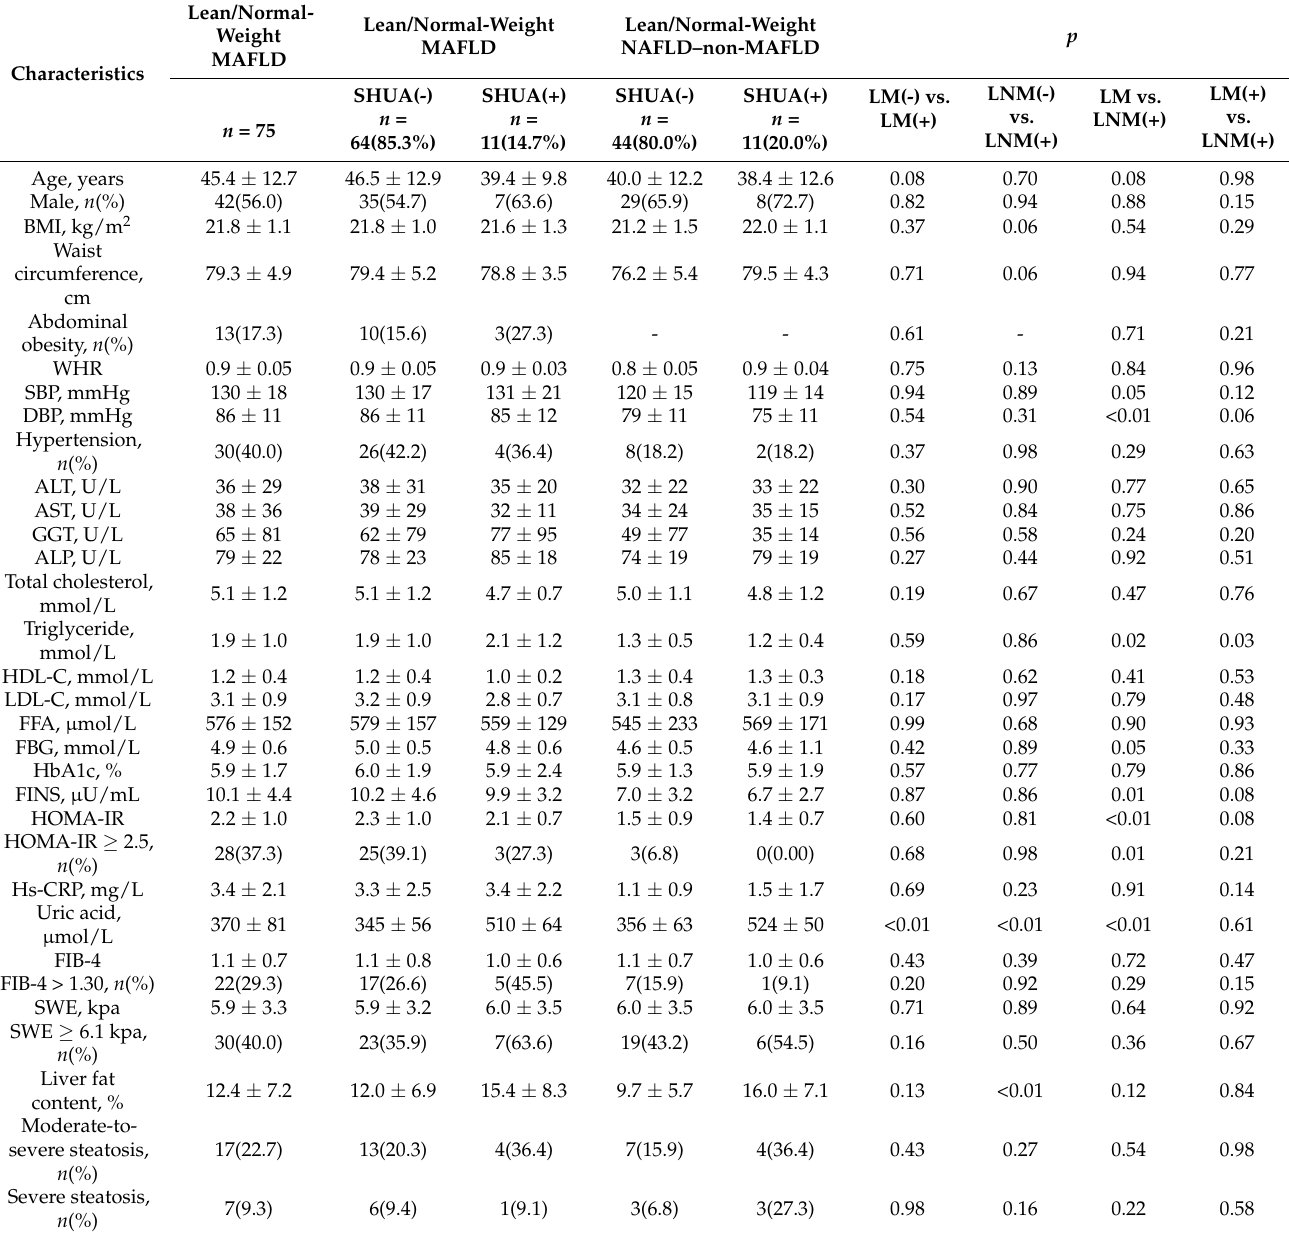
Table 2. Comparisons among lean/normal-weight MAFLD, lean/normal-weight MAFLD, and lean/normal-weight NAFLD–non-MAFLD with SHUA in patients with